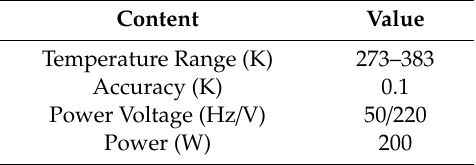
Table 4. The main technical parameters of the electric heating tube.